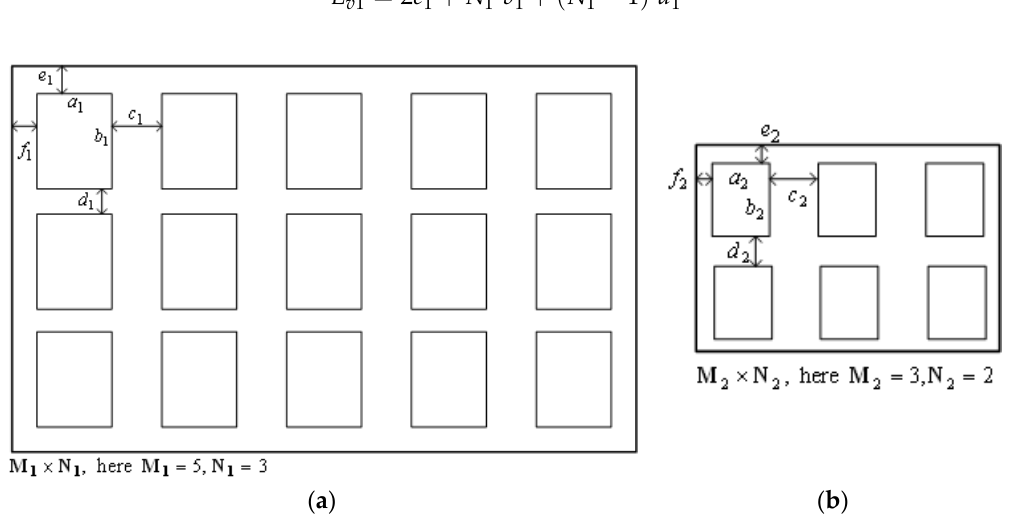
Figure 8. Distribution of windows: ( a ) original distribution; ( b ) possible distribution after the typification.